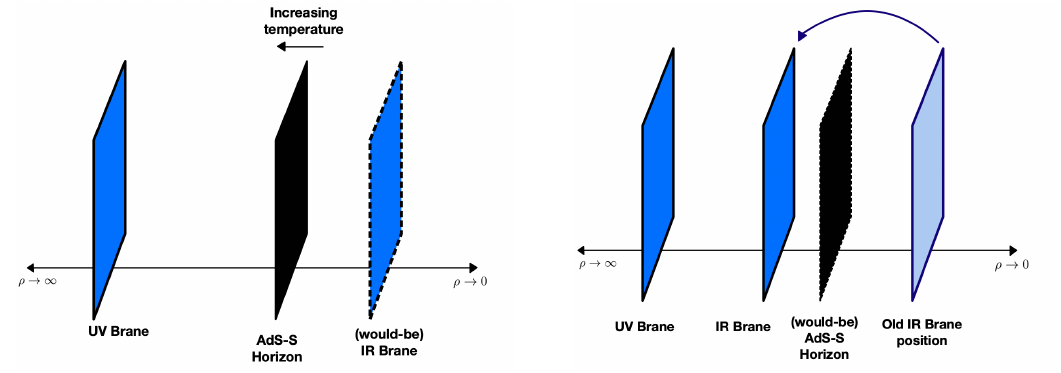
Figure 1 . Left hand diagram shows the high temperature behaviour of the RS model, while the right hand diagram shows the high temperature behaviour in the AD model. Beyond a certain temperature in the RS model the IR brane is stabilised behind the location of the horizon in the AdS-S phase, indicating that the model is unstable against black hole formation. In the AD model, this instability is lifted by introducing a temperature dependence to the stabilisation mechanism in such a way that the IR brane is stabilised outside the would-be horizon at high